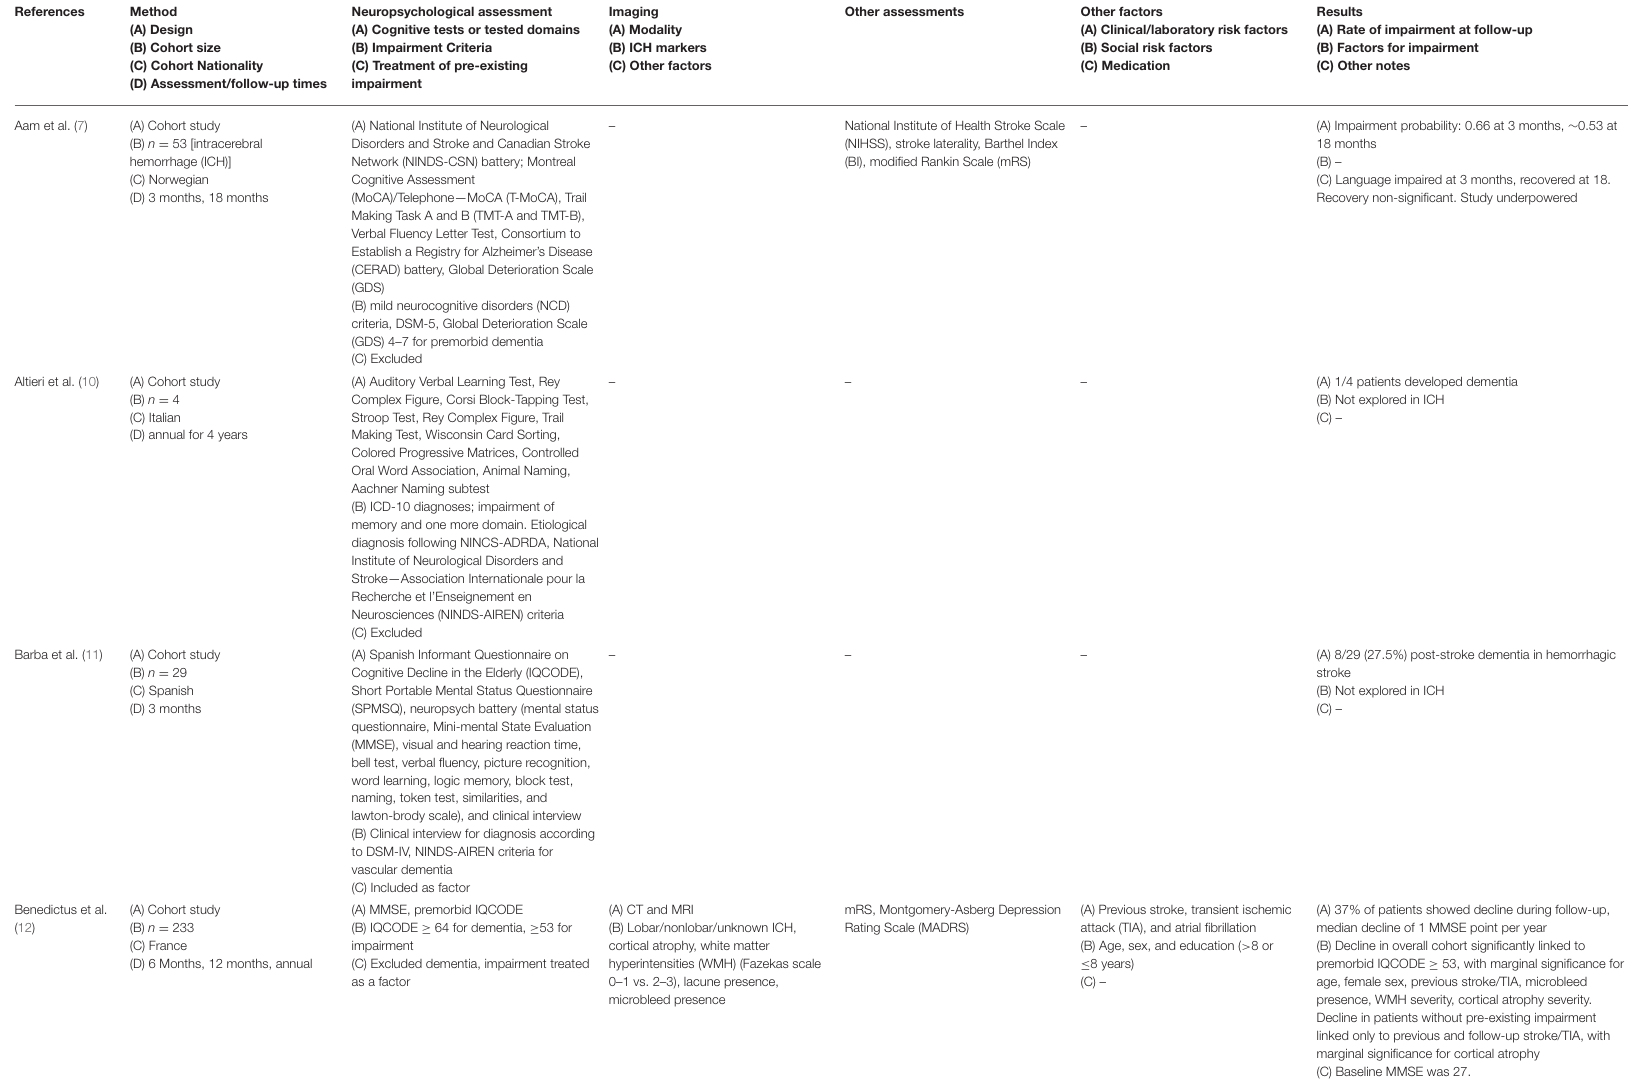
TABLE 1 | Summary of methods and findings from cohort